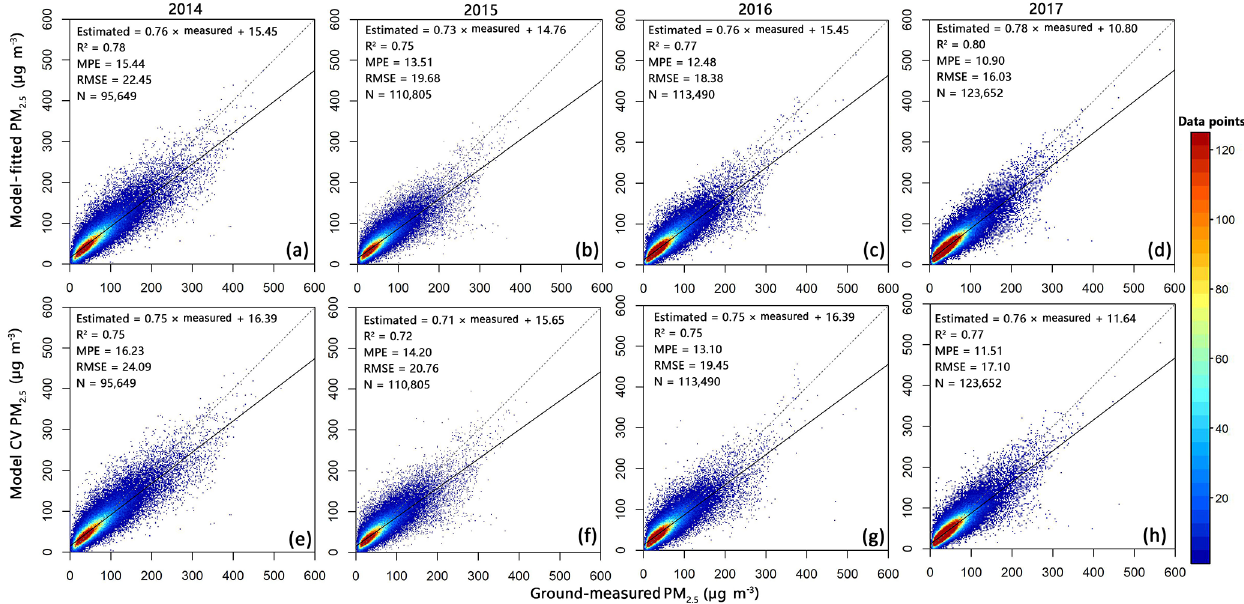
Figure 2. Model fitting (upper row) and cross-validation (CV, lower row) results for satellite PM 2 . 5 prediction models from 2014 to 2017.